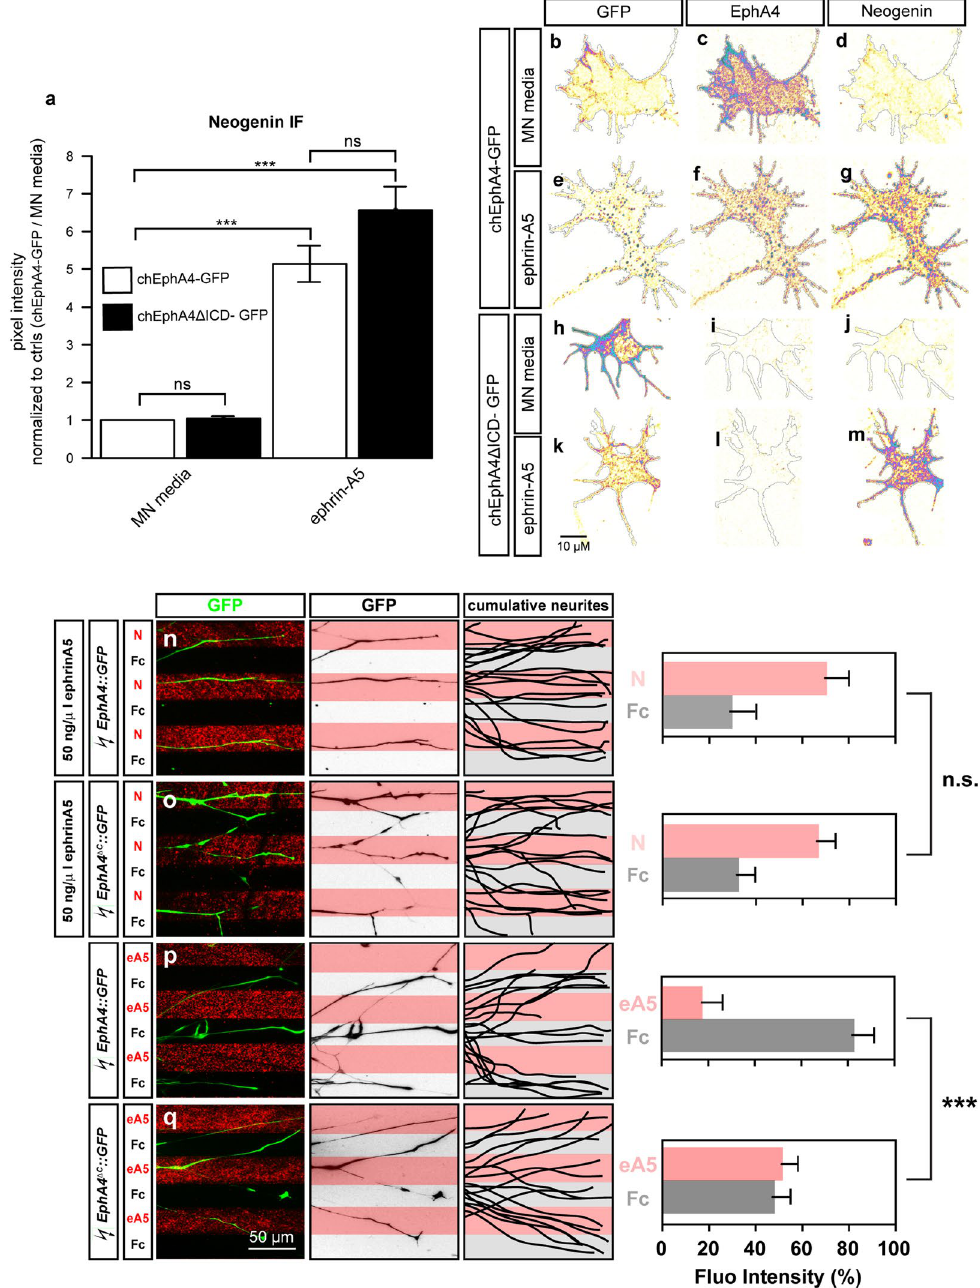
Figure 8. The cytoplasmic tail of EphA4 is dispensable in potentiating the ephrin-A5 induced increase in Neogenin protein levels and sensitization of LMC axons to netrin-1. ( a – m ) LMC explants from chick spinal cords electroporated with either a chEphA4-GFP or chEphA4 Δ ICD-GFP expression plasmids were subject to a 20 ′ treatment of either MN media or ephrin-A5 at 100 ng/mL and immunostained for Neogenin ( a ) Quantification of Neogenin IF in growth cones shows that the ephrin-A5 induced increase in Neogenin signal occurs in growth cones expressing both plasmids (chEphA4-GFP: 5.1 ± 0.5-fold increase, p = 0.001, N = 3; chEphA4 Δ ICD-GFP: 6.6 ± 0.6-fold increase p < 0.001, N = 4). ( b – m ) Examples of GFP, EphA4 and Neogenin IF in growth cones quantified in ( a ). ( n – q ) Growth preference on protein stripes exhibited by LMC axons. Left panels: explanted LMC neurites expressing chEphA4-GFP and chEphA4 Δ ICD-GFP on netrin-1 (N)/Fc stripes bath treatment of ephrin-A5 ( n , o ) or ephrin-A5 (eA5)/Fc stripes ( p , q ). Middle panels: inverted images of GFP signals shown at left panels. Right panels: superimposed images of five explants from each experimental group representing the distribution of GFP + LMC neurites. Quantification of lateral LMC neurites on first (pink) and second (pale) stripes expressed as a percentage of total GFP signals. Noted that both chEphA4-GFP and chEphA4 Δ ICD-GFP expressed LMC neurites show preferences over netrin-1 stripes. Minimal number of neurites: 85. Minimal number of explants: 13. N, netrin-1; eA5: ephrin-A5; error bars = SD; *** P < 0.001; statistical significance computed using Mann-Whitney U